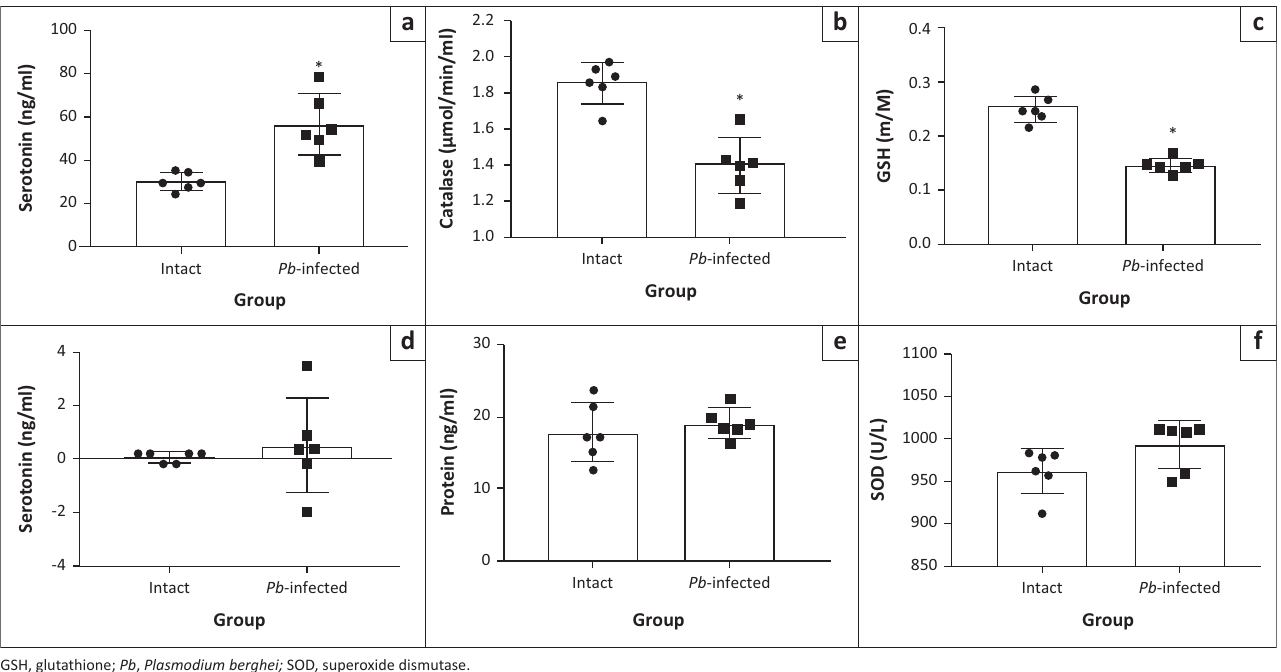
GSH, glutathione; Pb , Plasmodium berghei; SOD, superoxide dismutase. * , Significant difference at p < 0.05 compared to intact mice, unpaired t -test ( n = 6). FIGURE 9: Changes in neurotransmitter and antioxidant enzymes in the plasma of Pb -infected Swiss mice. (a) Plasma serotonin level. (b) and (c) Activities of catalase and glutathione peroxidase, respectively. (d) Plasma noradrenaline level. (e) Total plasma protein level. (f) Superoxide dismutase activity.